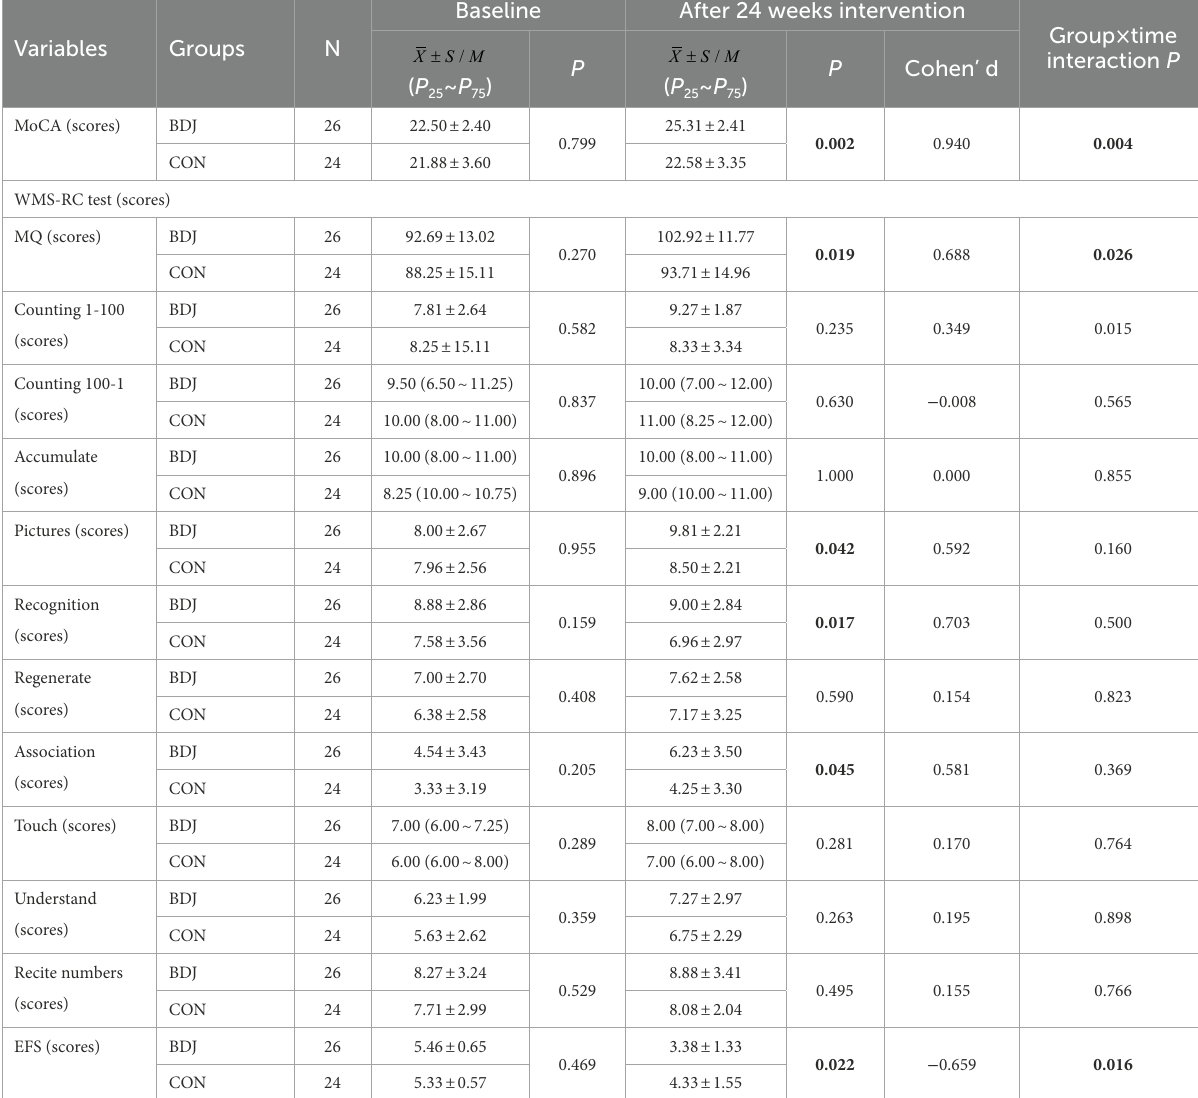
TABLE 2 Comparison of cognitive ability and physical frailty between groups at baseline and after 24 weeks intervention.